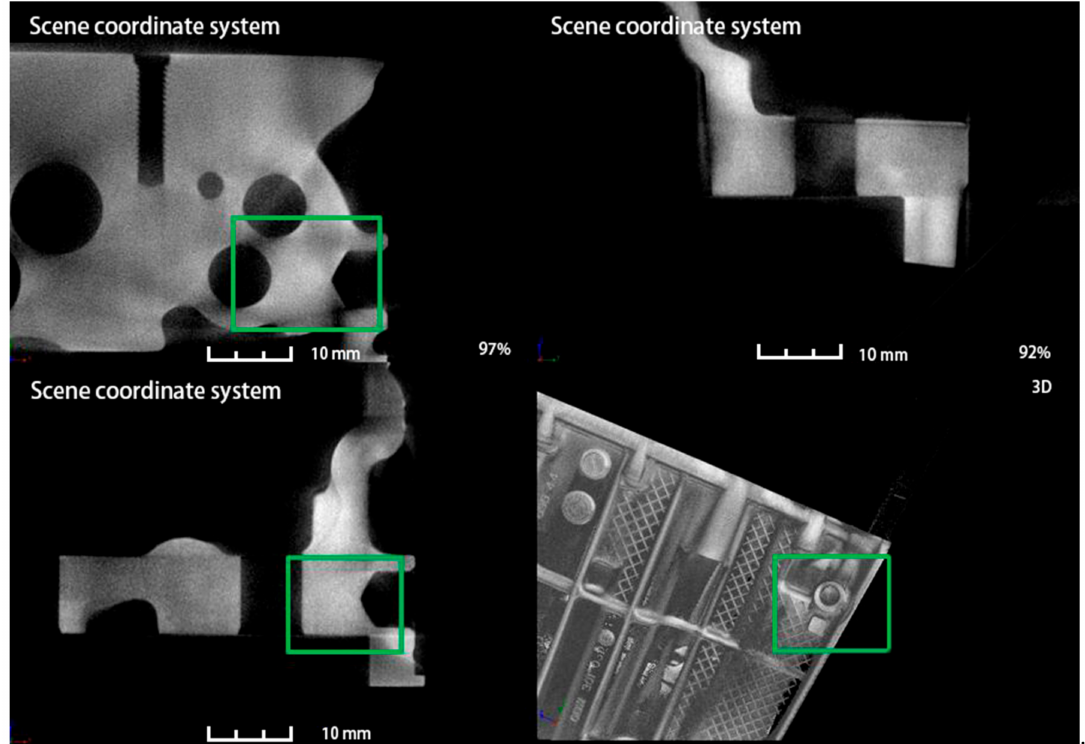
Figure 14. CT measurement results at the leakage site after